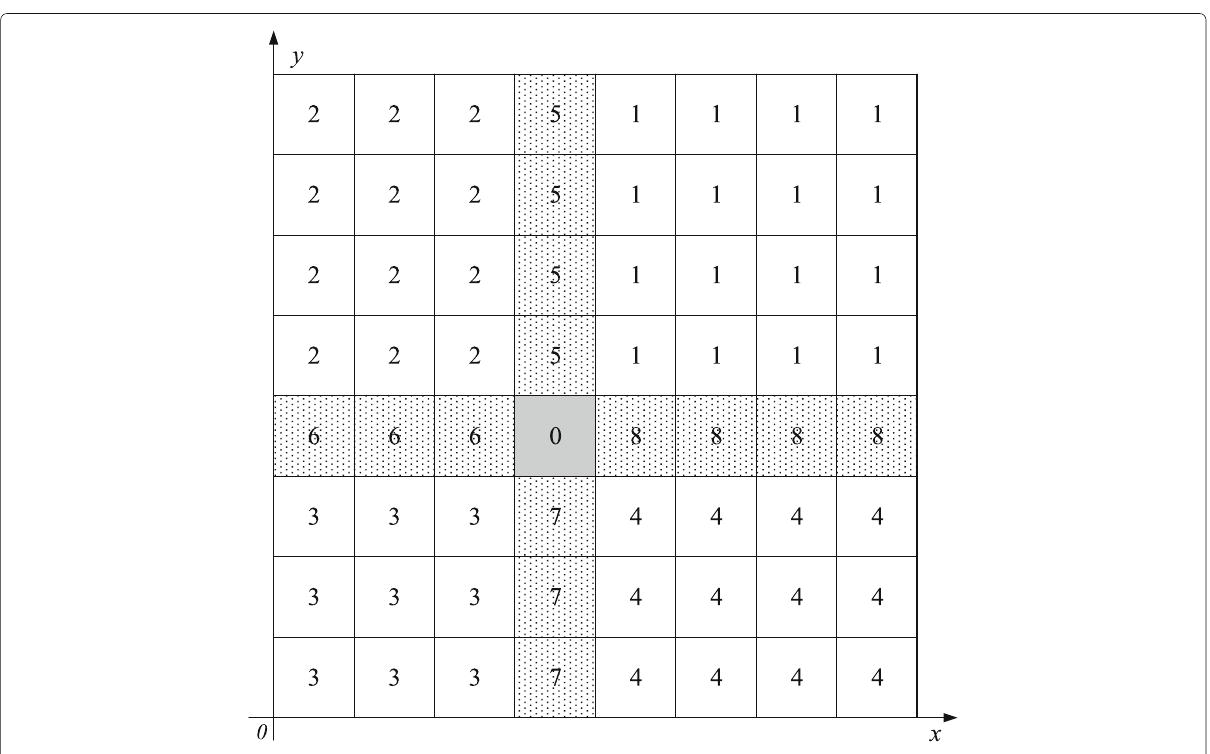
Fig. 4 The DN of virtual grid cell. The grid cell 0 is the cell wherein a mobile sink is located